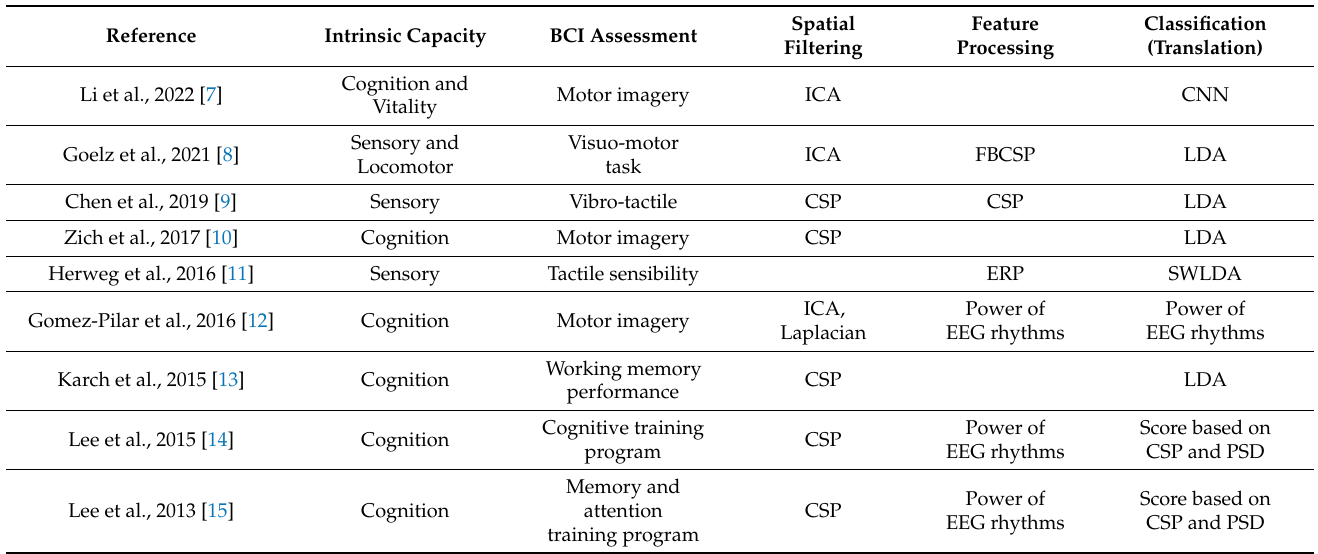
Table 2. Selected studies taking into account intrinsic capacity evaluation and processing. FBCSP: filter bank CSP. SWLDA: step-wise